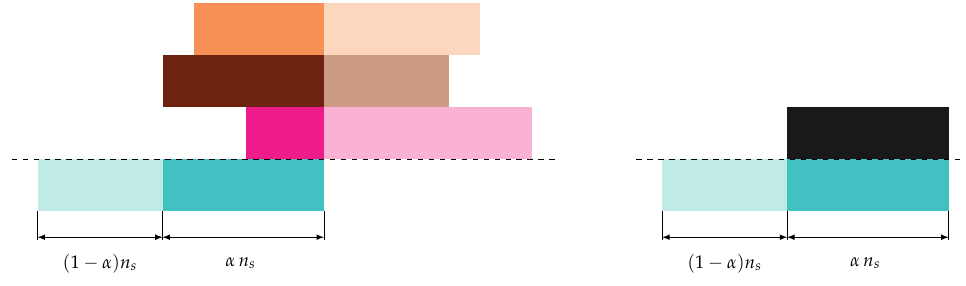
Figure 2. Collision of multiple users ( left ) and the abstracted surrogate model with constant interference power over α n s symbols ( right